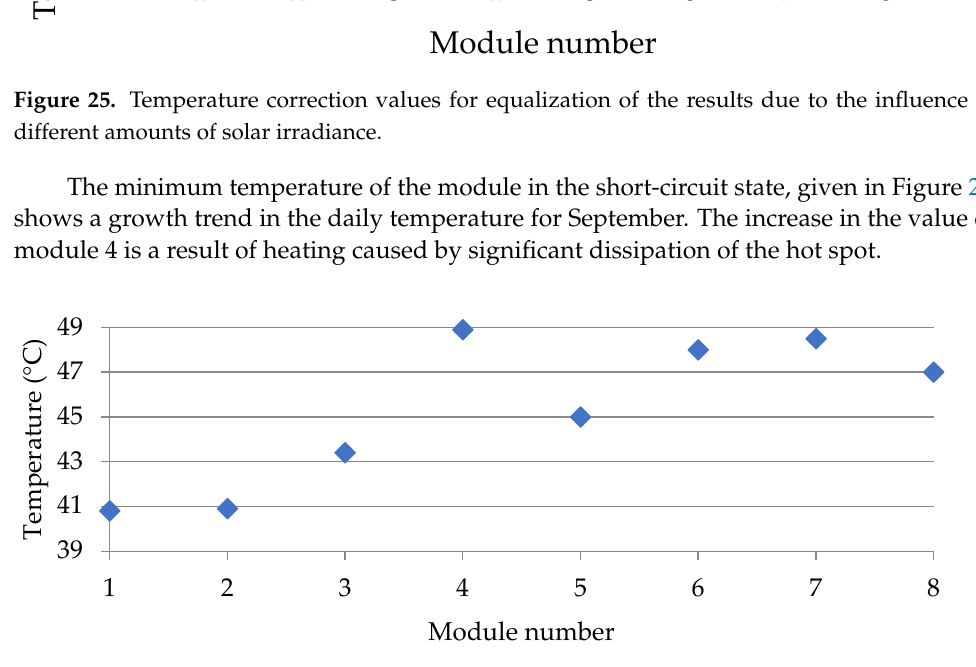
Figure 26. Minimum temperature of modules during measurements. Table 13. Numerical data comparison of the thermographic